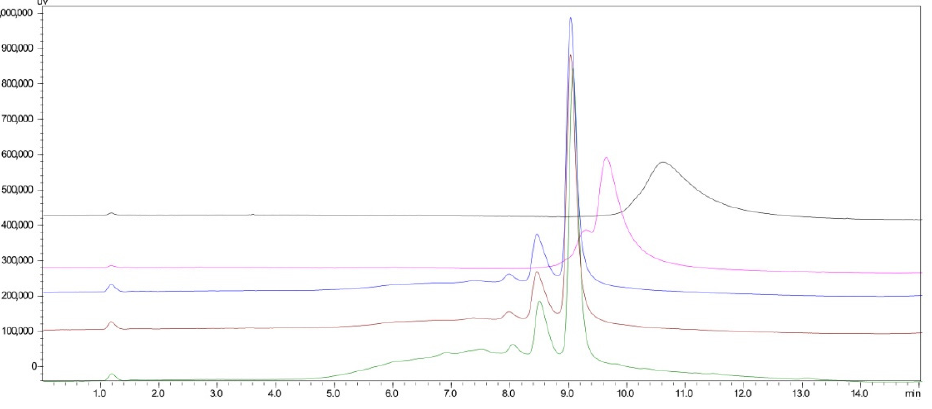
Figure 2. Effect of the borate buffer pH 9.5 (black line), 10.0 (fuchsia line), 10.5 (blue line), 11.0 (brown line), and 11.5 (green line) on the separation of Colistin A and B. line), and 11.5 (green line) on the separation of Colistin A and